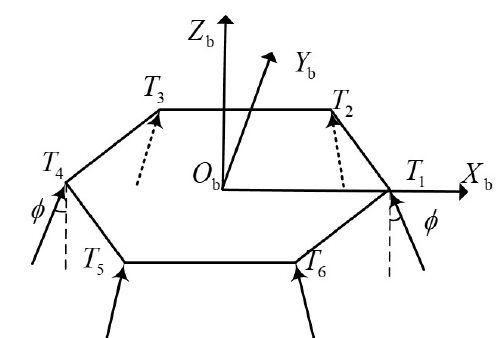
Figure 2. Lander body frame and thrusters layout. The thrusters are deployed in regular hexagon.